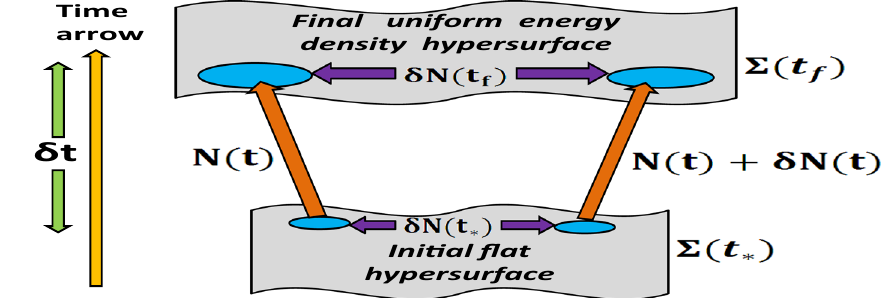
Fig. 16 Diagrammatic representation of δ N formalism